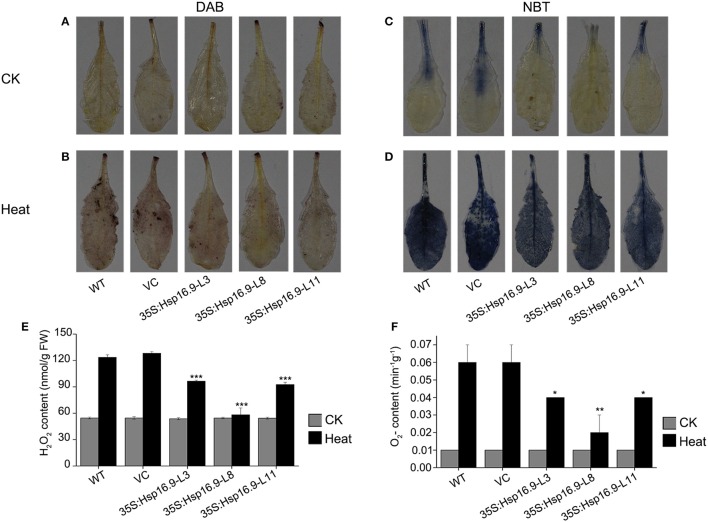
Changes in O2- and H2O2 levels in WT, VC and MsHsp16.9-overexpressing Arabidopsis plants after 45°C heat stress for 48 h. Heat-stressed leaves were incubated in nitroblue tetrazolium (NBT) or diaminobenzidine (DAB) solution. (A–C) Brown staining indicating H2O2 accumulation under normal and heat stress conditions. (D–F) Blue staining indicating O2- accumulation under normal and heat stress conditions. Bars represent the mean ± SE of three independent experiments. *and **Represent significant differences at p < 0.05 and p < 0.01 compared with WT plants. Bars represent the mean ± SE of three independent experiments. ***Represent significant differences at p < 0.001 compared with WT plants.